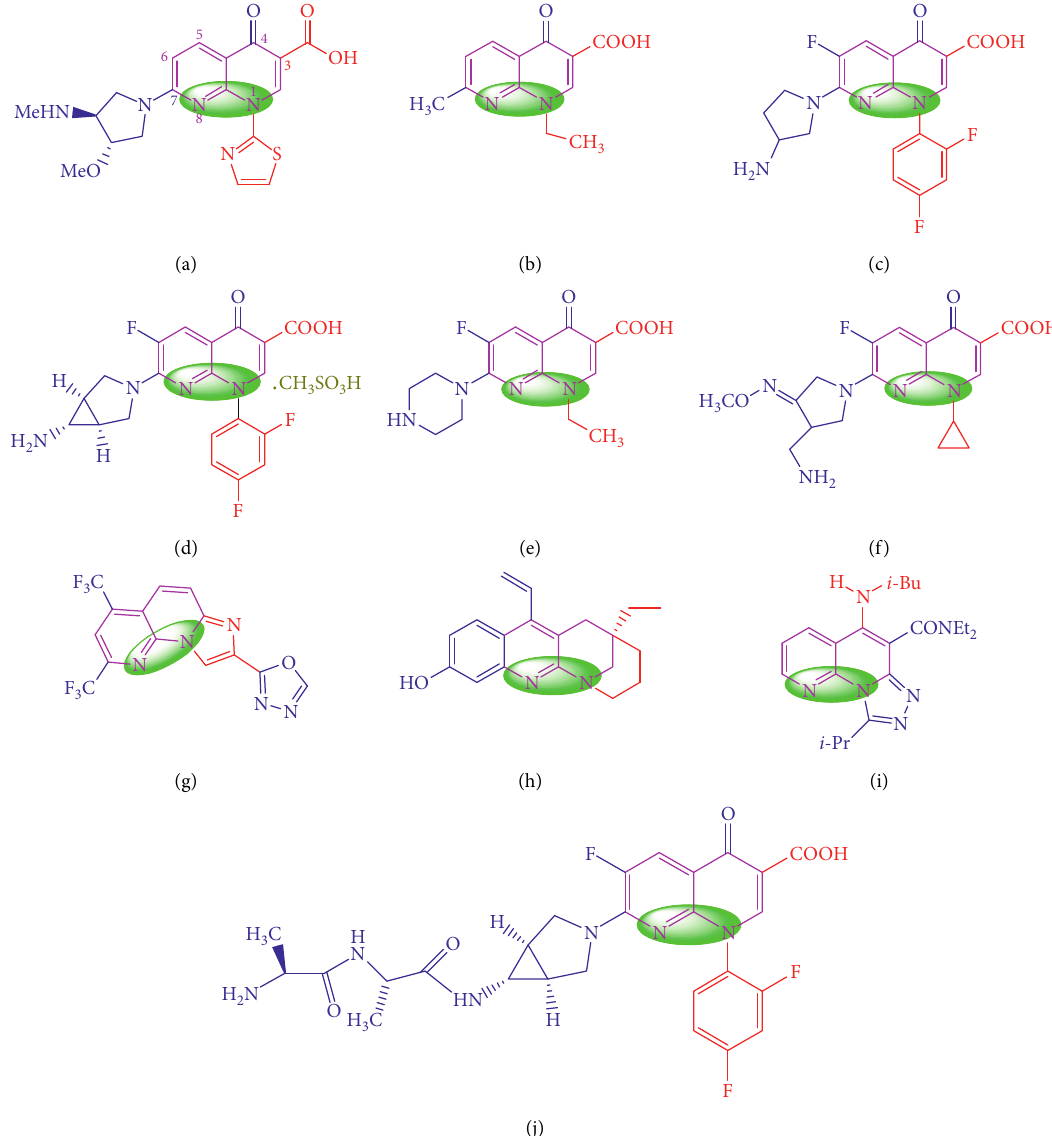
Figure 1: Available drugs having 1,8-naphthyridine nucleus. (a) Vosaroxin. (b) Nalidixic acid. (c) Tosufloxacin. (d) Trovafloxacin mesylate. (e) Enoxacin. (f) Gemifloxacin. (g) RO8191. (h) Eucophylline. (i) NF 161 . (j)